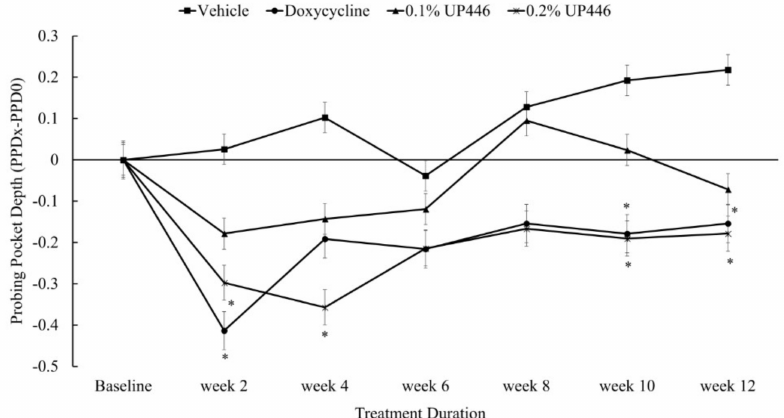
Figure 4. Changes in mean periodontal pocket depth in beagle dogs with ligature-induced periodontitis. Values are represented as di ff erences between before and after treatment. *; denote significance at p < 0.05 when compared with placebo and treated groups at the same